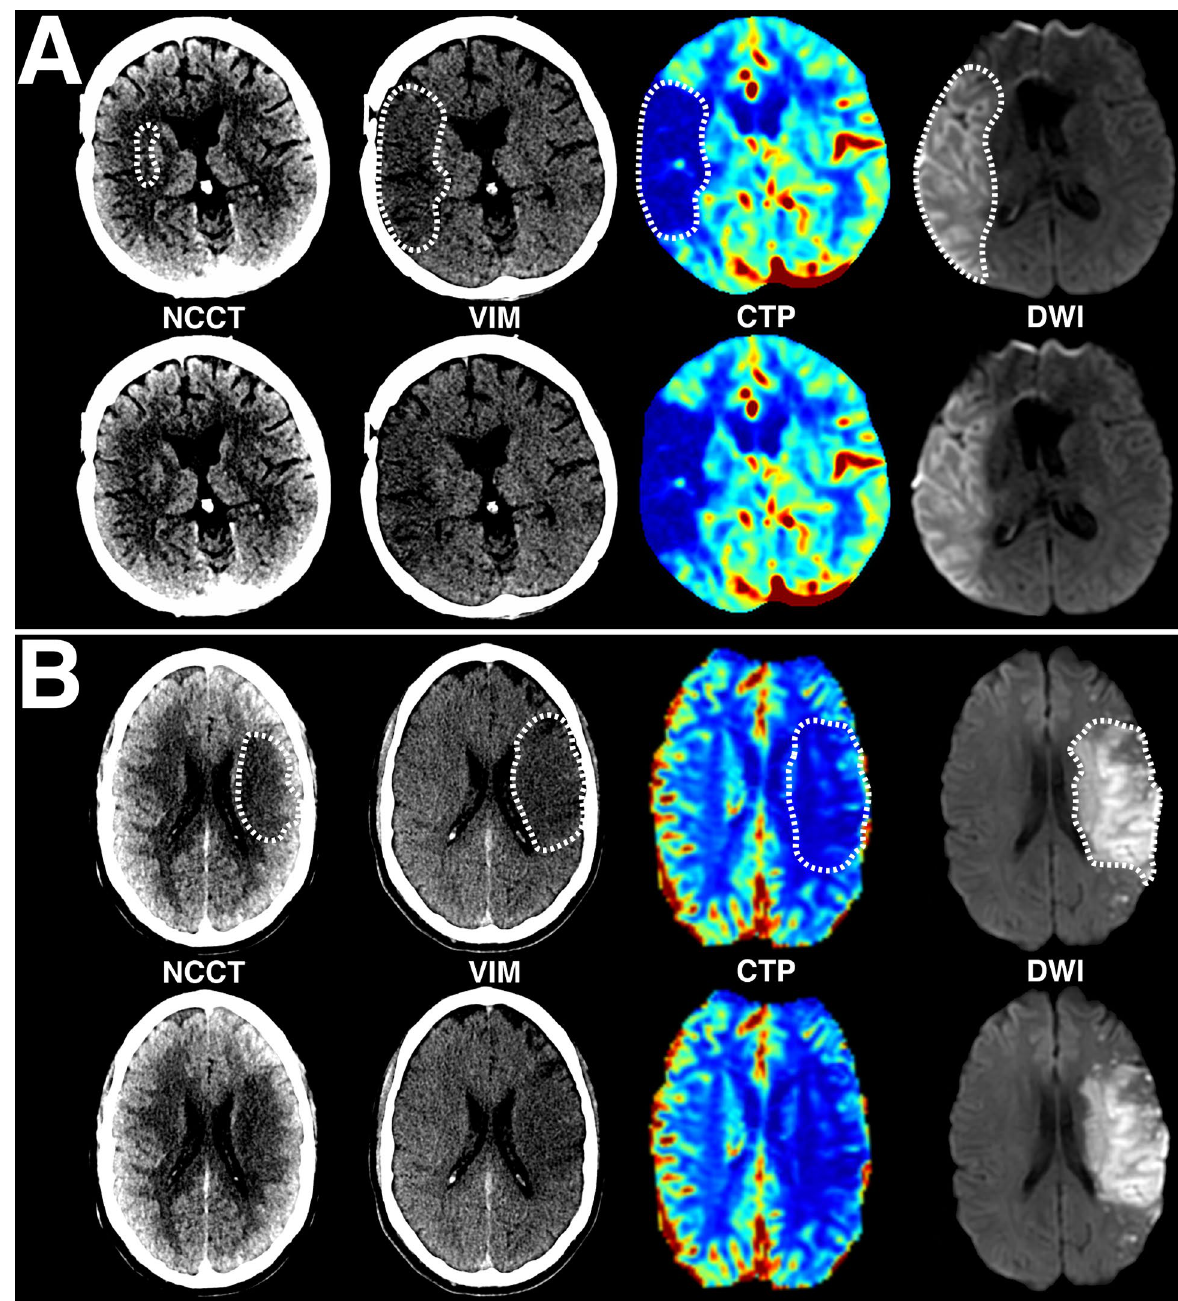
Figure 1. Examples of ischemic core conspicuity compared between CT and DWI methods. ( A ) Example case of a 49-year-old female presenting in the early-window with an occlusion of the proximal M1 segment of the right middle cerebral artery and a large core infarct. Please note that this patient had a distant history of right- sided craniotomy for anterior communicating artery aneurysm clipping, with evidence of the prior craniotomy seen on the CT images, and susceptibility artifact from the aneurysm clip visible on the DWI image adjacent to the frontal horn of the right lateral ventricle. ( B ) Additional example case of a 43-year-old male presenting in the late-window with an occlusion of the proximal M1 segment of the left middle cerebral artery and a large core infarct. For both patients, axial non-contrast CT (NCCT), virtual ischemia map (VIM), CT perfusion cerebral blood flow map (CBF) and diffusion-weighted MRI (DWI) images are presented. Note the increased conspicuity of the ischemic core on the axial non-contrast VIM series relative to the NCCT, using the same window width (40) and level (25) settings for each image. Within the same territory, reduced CBF and corresponding diffusion restriction on subsequent MRI confirm the territory of infarction. All regions of visible ischemic core are outlined by hashed white lines in the top row for each patient, with unannotated versions provided in the bottom row. Postprocessed DECT and perfusion images were automatically generated using Syngo.via (Siemens Healthcare, Munich, Germany) and RAPID (iSchemaView, Menlo Park, CA),